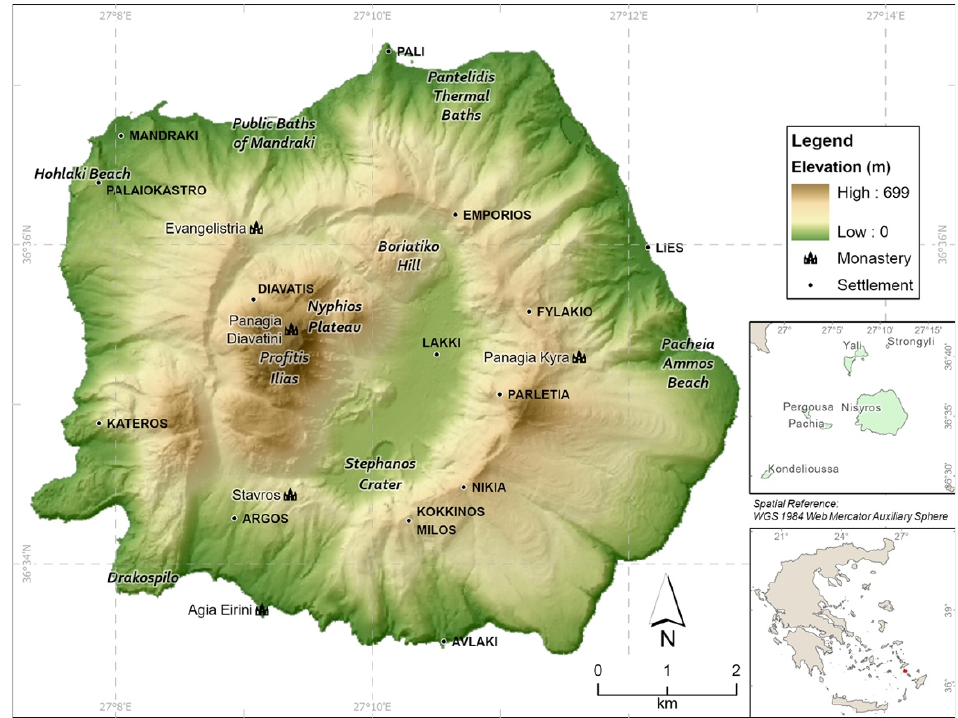
Figure 2. Digital Elevation Model (DEM) of Nisyros volcanic island. Main localities are also presented.